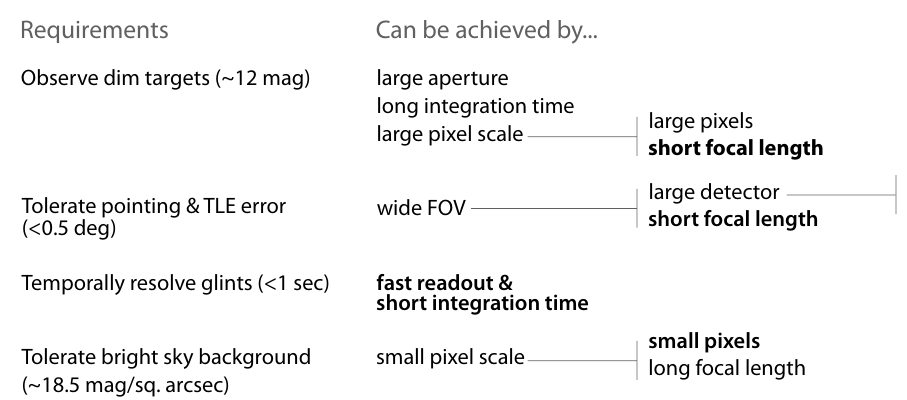
Figure 3. Electro-optical system requirements and design options for observing small satellites and debris. Text in bold represents options chosen by the OSCOM system.